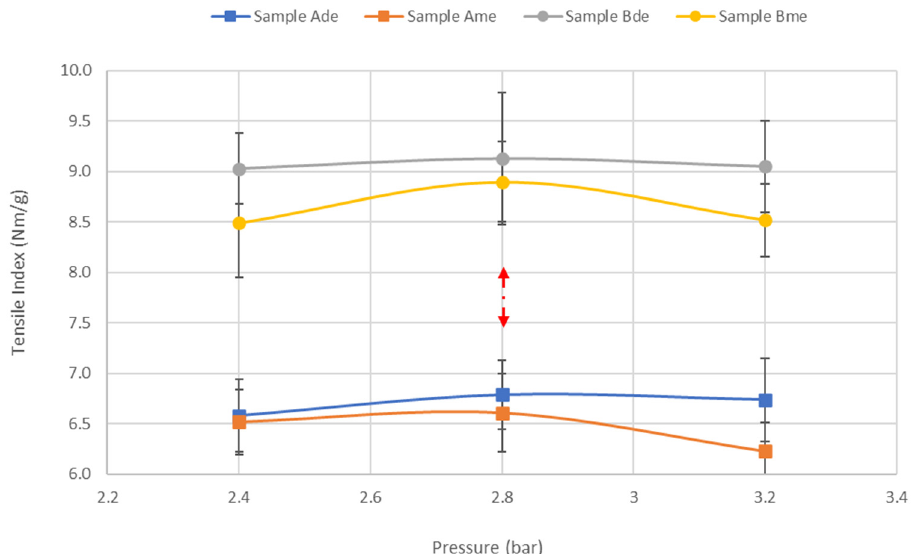
Figure 9. Results obtained for tensile index with the pressure increase in the samples A and B with deco and micro embossing.